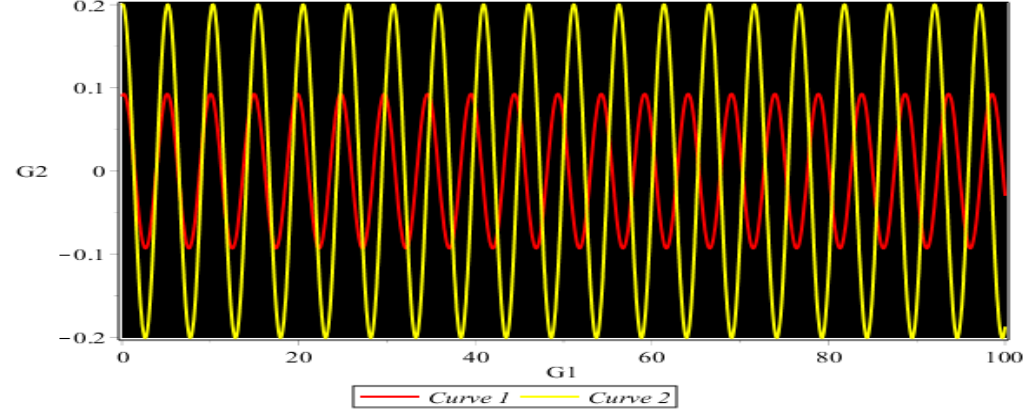
Figure 7. Sensitivity presentation for curve 1 at (0.04, 0.03) and curve 2 at (0.4, 0.02).